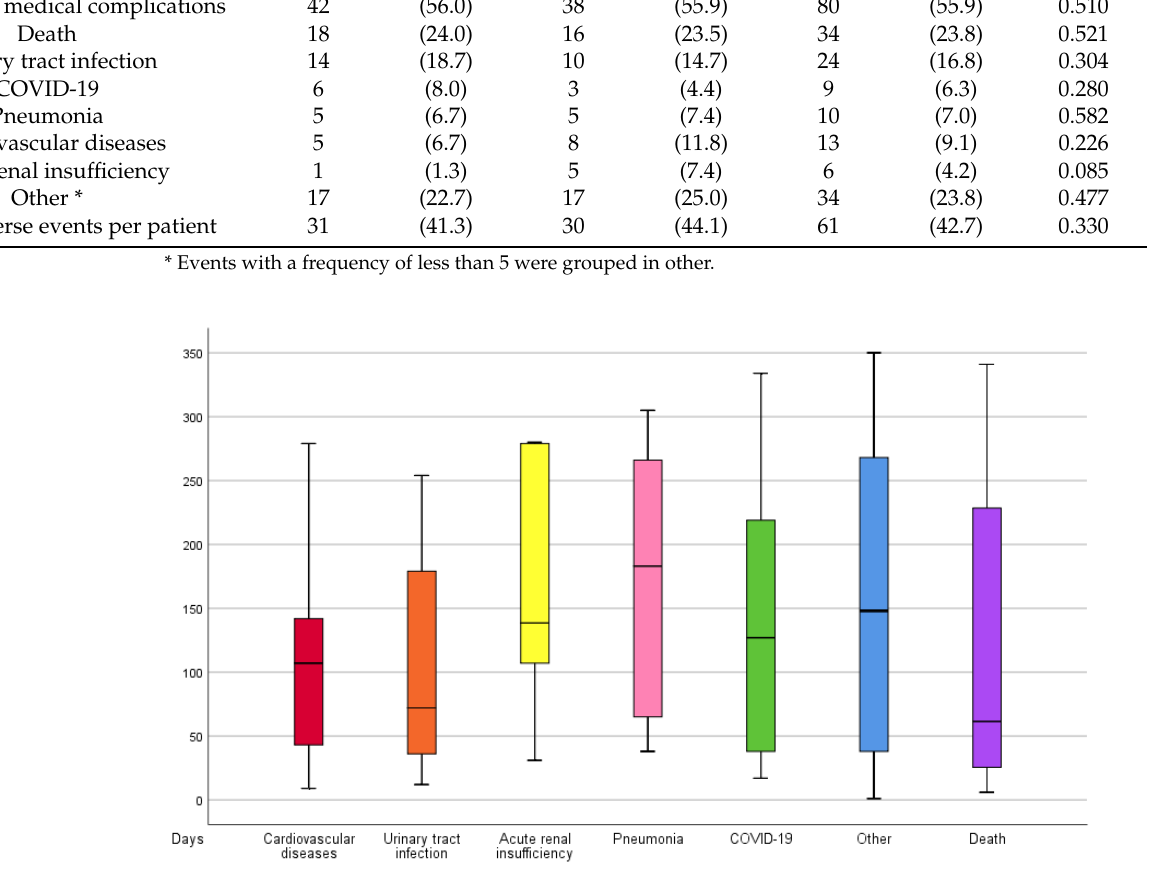
Figure 3. Patients’ survival by patien ts by group. In the QoL analysis, 128 (89.5%) of the 143 patients that underwent surgery were included. The global assessment of quality of life measured with the VAS prior to the fracture was 63.4 and 39.0 after the fracture at hospital admission. In successive follow- ups after surgery, VAS improved significantly ( p < 0.0001) but without reaching baseline values and without differences between groups (Supplementary Table S1). The QoL index evaluated with the EQ-5D-5L instrument had an average of 0.555 be- fore the fracture and decreased to -0.349 before surgery. After surgery, patients had a pro- gressive and significant increase in QoL index scores, reaching up to 0.340 at 12-month follow-up ( p < 0.0001), with no difference between groups (Supplementary Table S1).